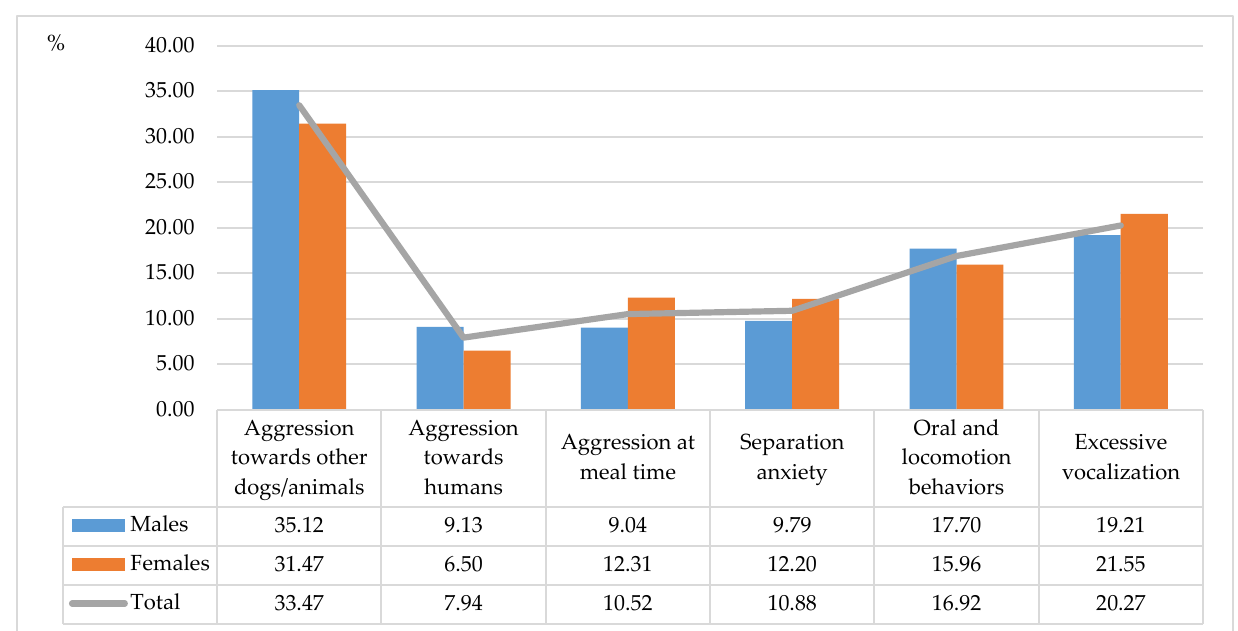
Figure 1. Incidence of undesirable behaviors in the examined dog breeds (%).